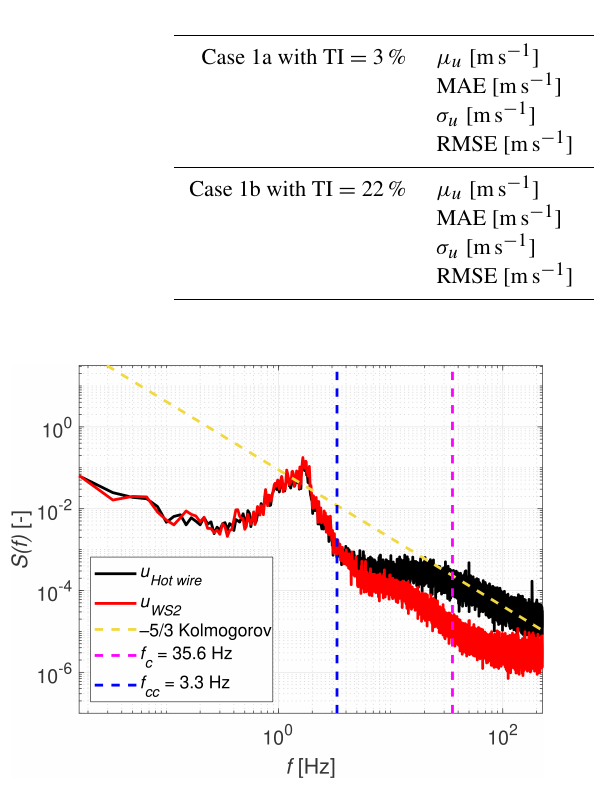
Figure 12. Spectrum of WindScanner 2 and the hot-wire anemome- ter for a turbulence intensity of 22% (Case